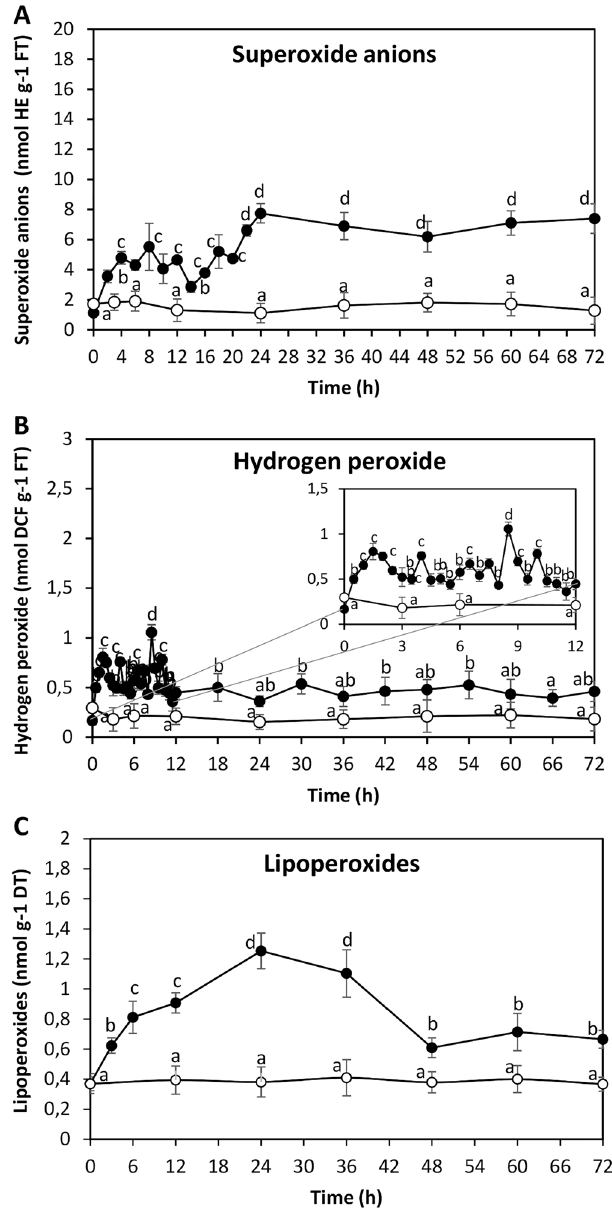
Figure 3. Level of superoxide anions ( A ), hydrogen peroxide ( B ) and lipoperoxides ( C ) in U. lactuca cultivated without ANT (open circles) and with 5 μM of ANT (black circles) for 0–72 h. The level of superoxide anions and hydrogen peroxide are expressed as nanomole per gram of fresh tissue (FT) and lipoperoxides in nanomole per gram of dry tissue (DT) and time in hours. The subframe represents the level of hydrogen peroxide from 0 to 12 h of culture. Symbols represent mean values of three independent experiments ± SD. Letters indicate significant differences among experiments ( P <